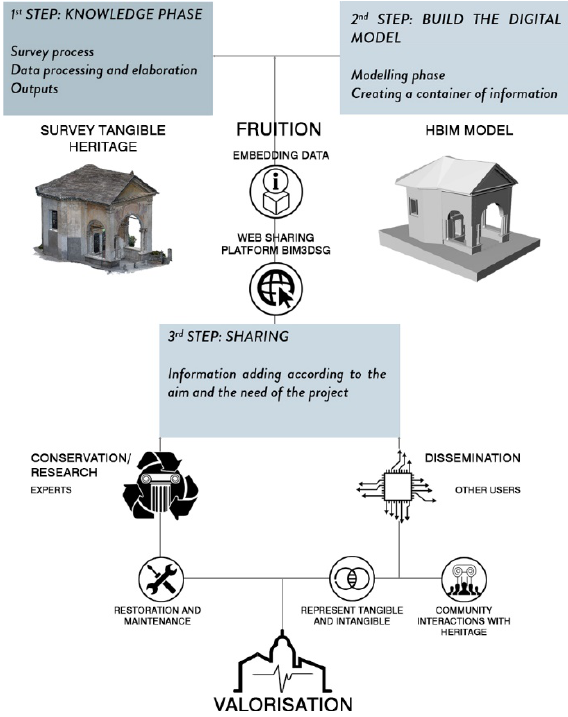
Figure 2: Pipeline from survey data to HBIM modelling, web sharing access and final